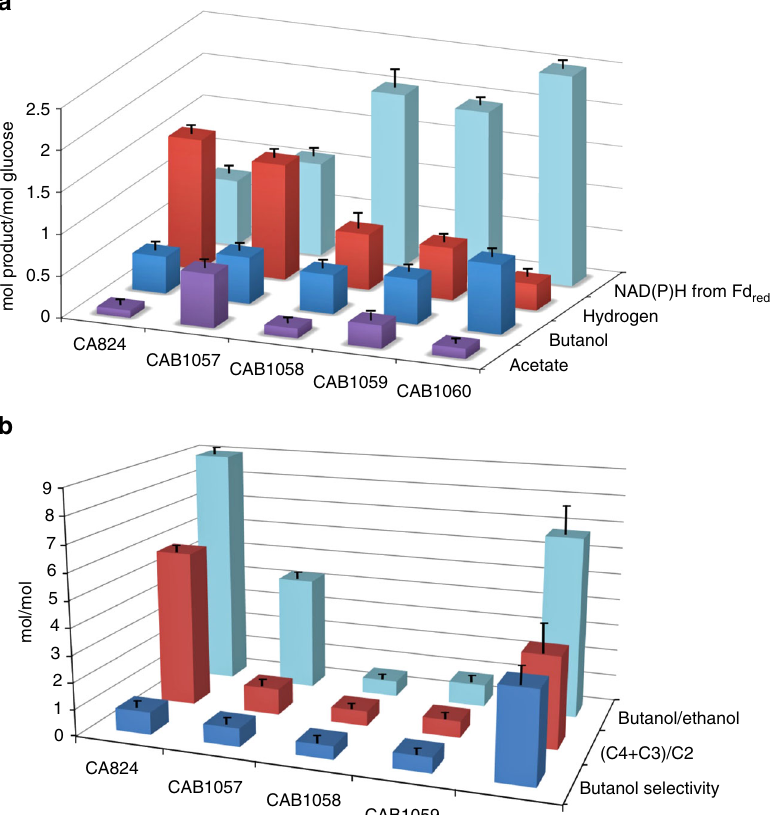
Fig. 2 Optimization of the n -butanol-producing strain. All strains were evaluated in phosphate-limited chemostat cultures at pH 4.4 for wild type and 5.0 for all the other strains. All the engineered strain produced no acetone, lactate, and butyrate. a n -Butanol, acetate, hydrogen, and NAD(P)H from Fd red yields (mol/mol glucose). b Product ratios (mol/mol). (C4 + C3)/C2 = (Butanol + Butyric acid + Acetone)/ (Ethanol + Acetic acid). Butanol selectivity = Butanol/( Σ of all products except butanol). Error bars represent SD of three biological